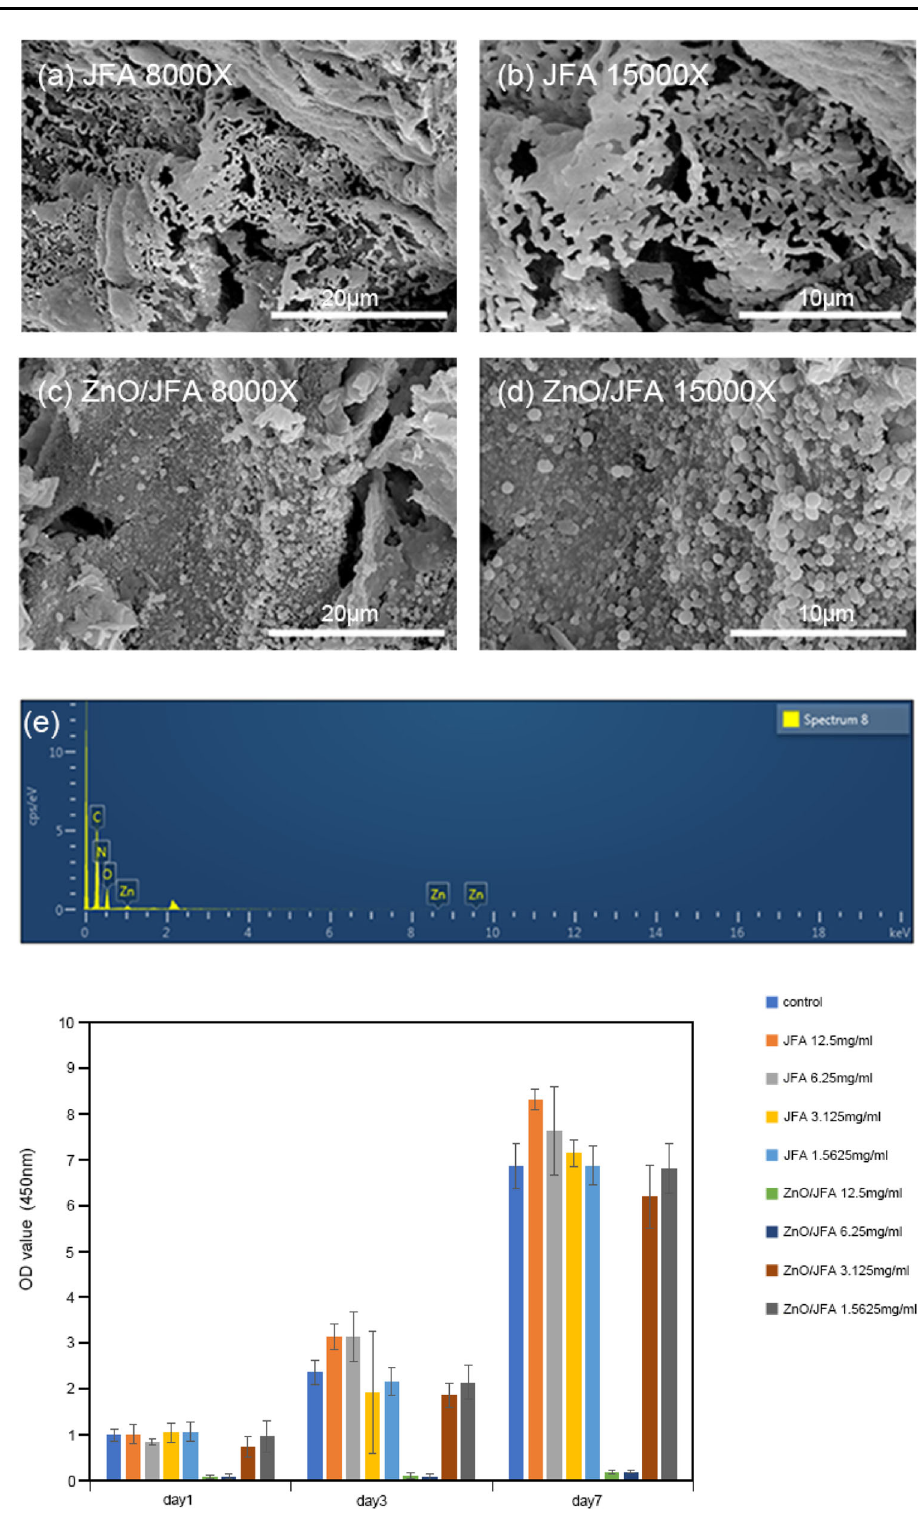
Fig. 2 SEM images of JFA and ZnO/JFA at different magni fi cations: a MPC 8000X JFA, b MPC 15000X JFA, c MPC 8000X ZnO/JFA and d MPC 15000X ZnO/JFA. e Element analysis spectrum of the corresponding sample